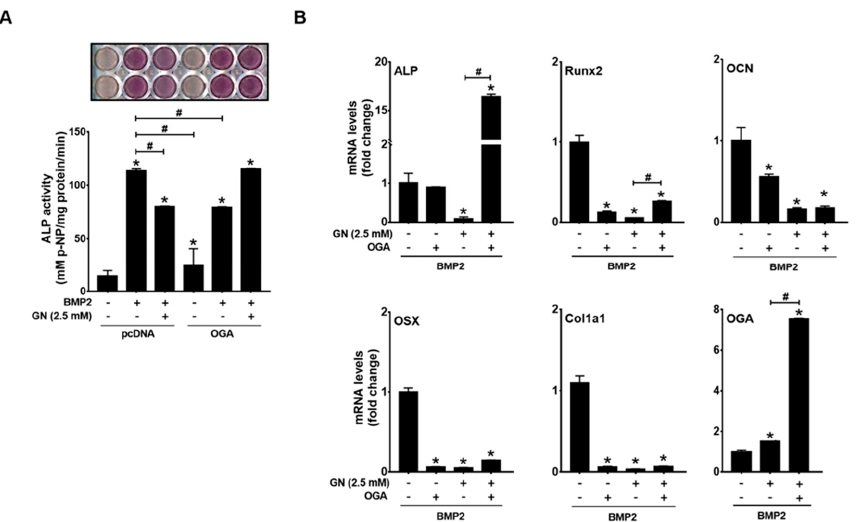
Figure 4. OGA overexpression rescued BMP2-induced osteogenic differentiation under excessive O - O -GlcNAcylation conditions. C2C12 cells were transfected with OGA expression plasmids and osteogenic differentiation was induced by BMP2 in the presence or absence of N -acetylglucosamine (GN). Subsequently, ALP staining and ALP activity assays ( A ) or qRT-PCR analysis ( B ) were performed. * p < 0.05 compared with the non-treatment control; # p < 0.05 for the indicated